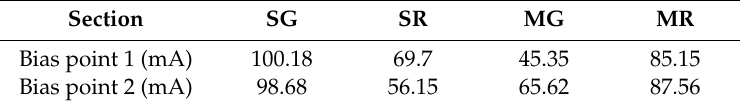
Table 5. Bias points for frequency response